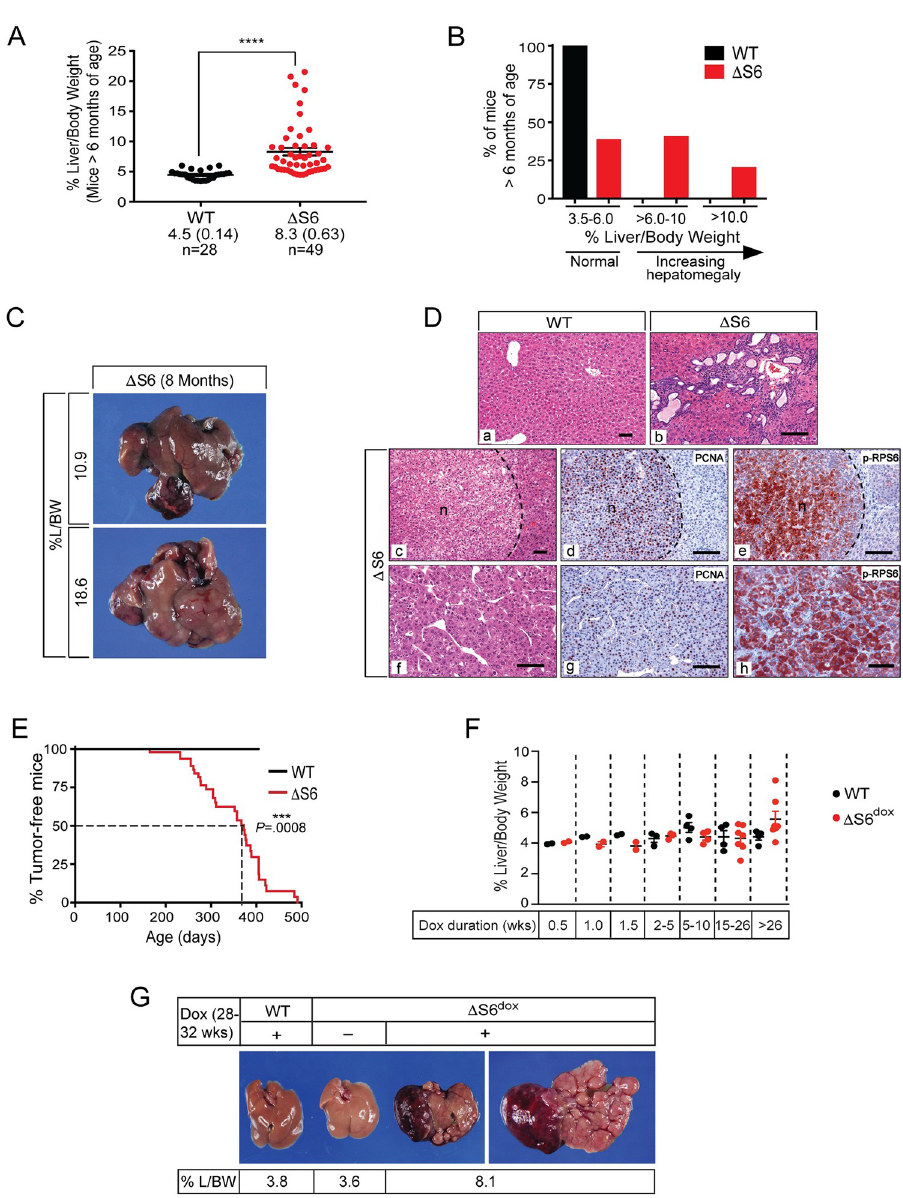
Fig 5. Rps6-deficient livers overgrow and are predisposed to spontaneous tumor development. (A) Graph of % liver/body weights (% L/BW) in WT and Δ S6 mice at � 6 months of age showing that many Δ S6 livers have grown to exceed normal size. Data are mean ( ± SEM); ���� P < .0001; 2-tailed unpaired Student’s t -test. (B) Graph showing % of WT and Δ S6 mice at � 6 months of age with % L/BWs in normal range (3.5–6%) or larger than normal ( > 6%). (C) Photomicrographs of livers from 2 Δ S6 mice at ~8 months of age. Livers have grown to 2–3 times normal size and are grossly misshapen due to abnormal nodular growth. (D) Photomicrographs of H&E stained slides and IHC of livers from WT (a) or Δ S6 mice at � 6 months of age (b-h) showing bile duct hamartomas (b) and tumors with compact nodular (c) or trabecular growth patterns (d). IHC for PCNA (d and g) and phospho-RPS6 (Ser235/6) (e and h) show that tumors are comprised of highly proliferative cells that display activation of mTOR. AEC chromagen (red/brown); hematoxylin counterstain (blue). Original magnifications; a, c, x 62.5; b, d-h, x 125 (scale bars, all 50 μ ). (E) Kaplan- Meier curve showing % of WT and Δ S6 mice that are tumor-free at � 6 months of age. 50% of Δ S6 mice have developed at least 1 tumor by 372 days. P = .0008 (Log-rank (Mantel-Cox) test). (F) Graph of %L/BWs of WT and Δ S6 dox mice showing that some Δ S6 dox livers (2/7 (28.6%)) have also overgrown after being maintained on dox for > 26 weeks of age. While none of the dox treatment durations result in significantly different % L/BWs between WT and Δ S6 dox mice, there is a trend towards hepatomegaly in Δ S6 dox mice with increasing time on dox (2-tailed unpaired Student’s t -test). (G) Photomicrographs of livers from a WT mouse provided with 250 μ g/ml dox for 7 months (3.8%